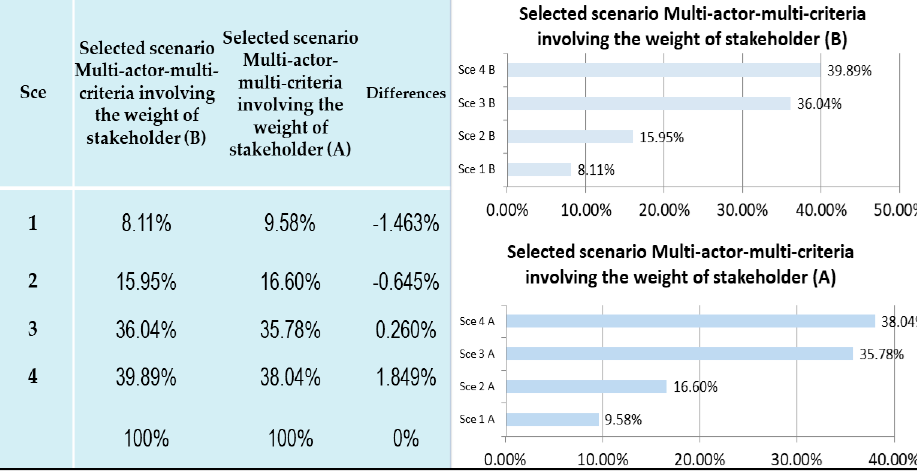
Figure 13. Results of the assessment of multi-actor multi-criteria analysis (method A) and multi-actor multi-criteria analysis with weight of stakeholder involvement (method B) .